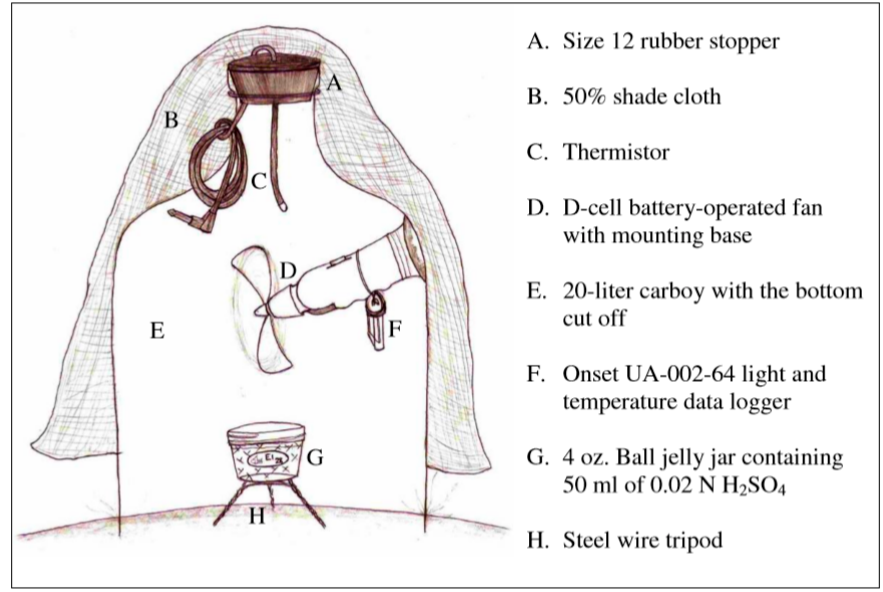
Figure 2. Schematic representation of apparatus used for collecting NH3-N from manured soils.